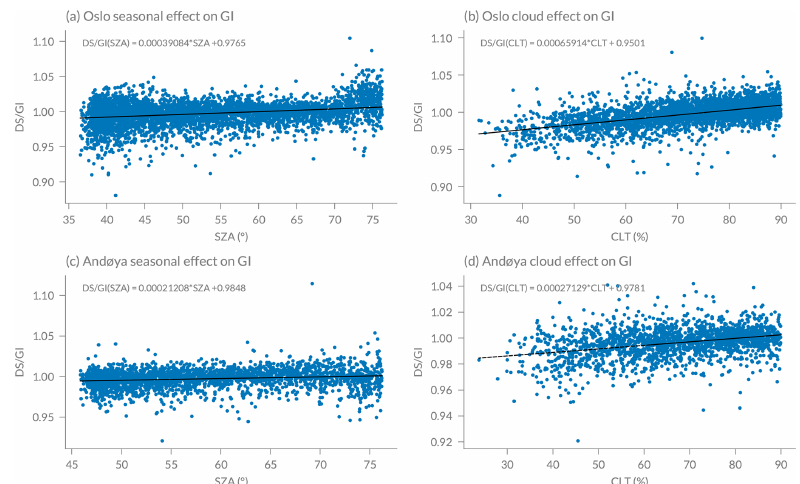
Figure A1. Linear relationships between the DS / GI ratio and (a, c) the solar angle (SZA) as well as (b, d) the cloud transmittance (CLT) for Oslo (1995 to 2020) and Andøya (2000 to 2020).